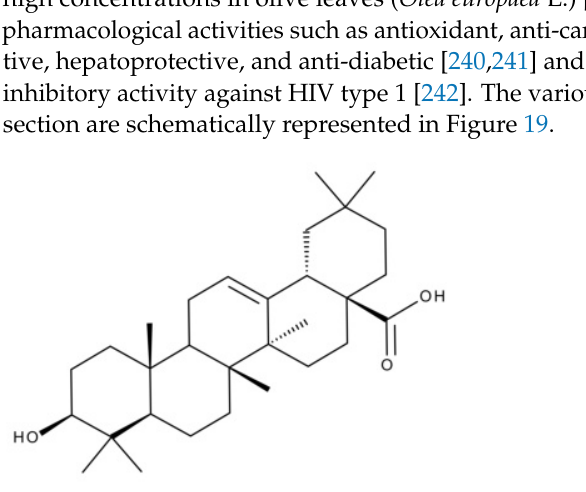
Figure 18. Chemical structure of oleanolic acid.